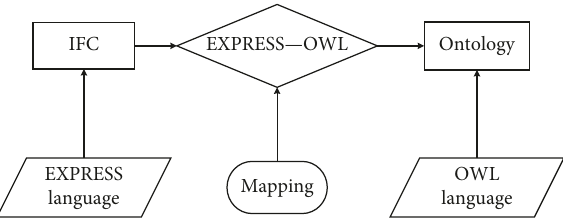
Figure 4: Diagram of IFC data